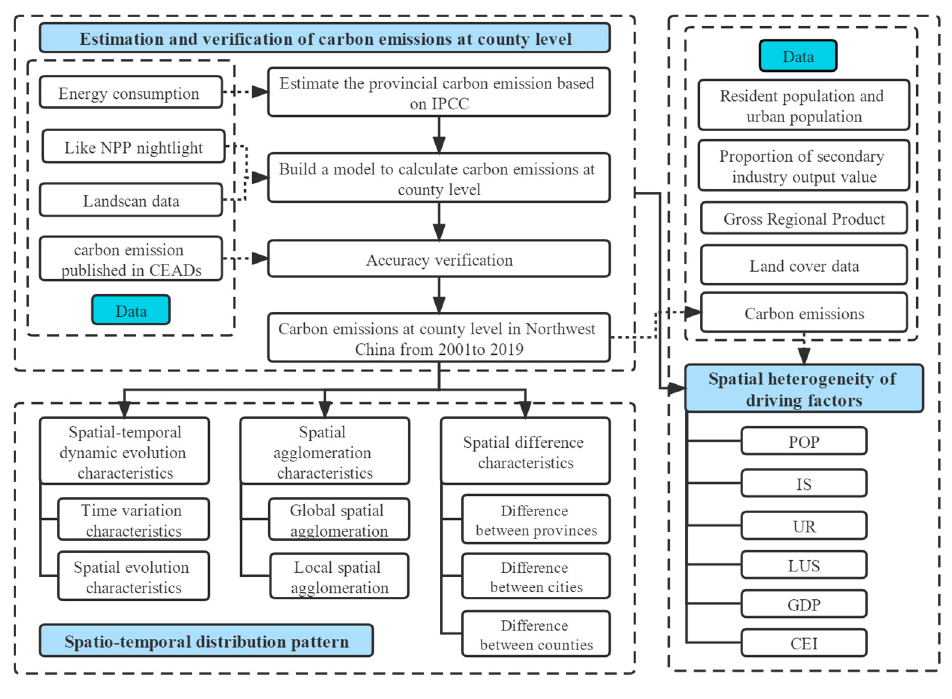
Figure 2. Flow-process diagram.